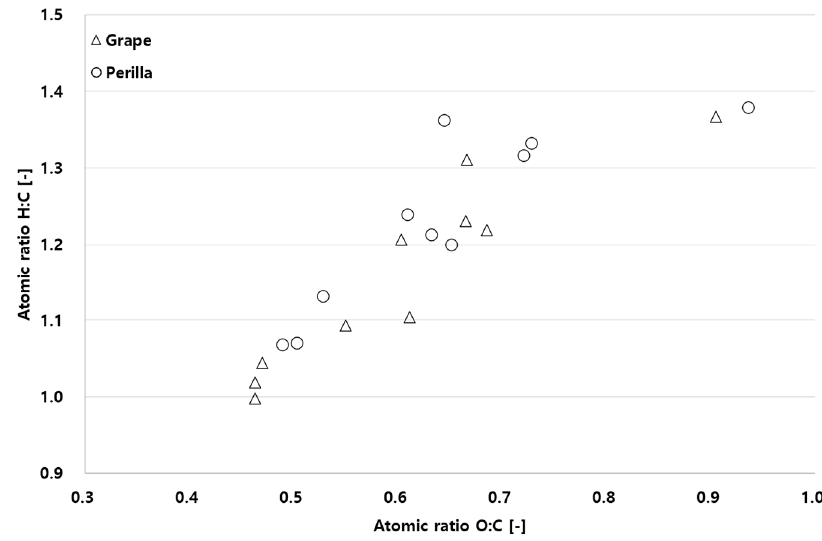
Table 3. Energy yield of torrefied grape and perilla.